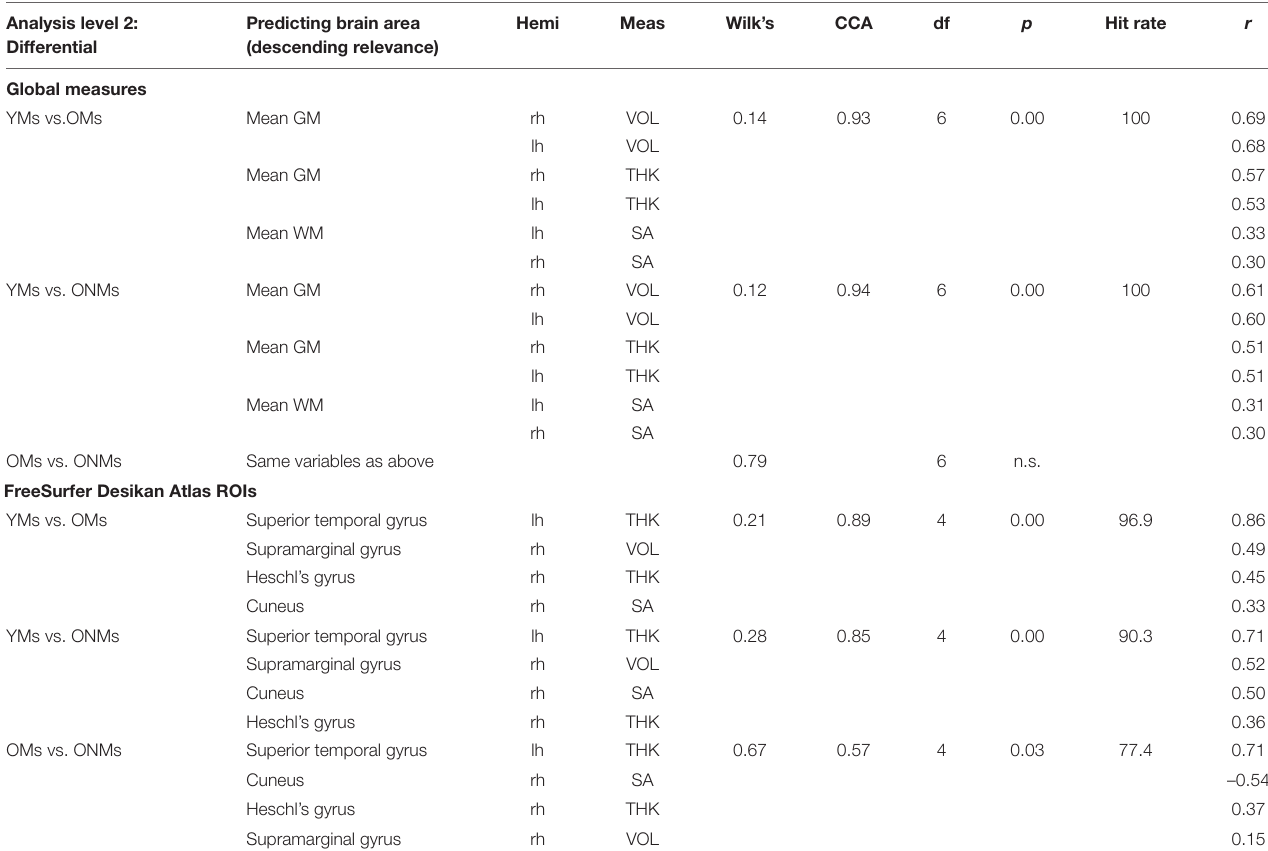
TABLE 4 | Significant structural ROIs of the discriminant function analysis. Analysis level 2: